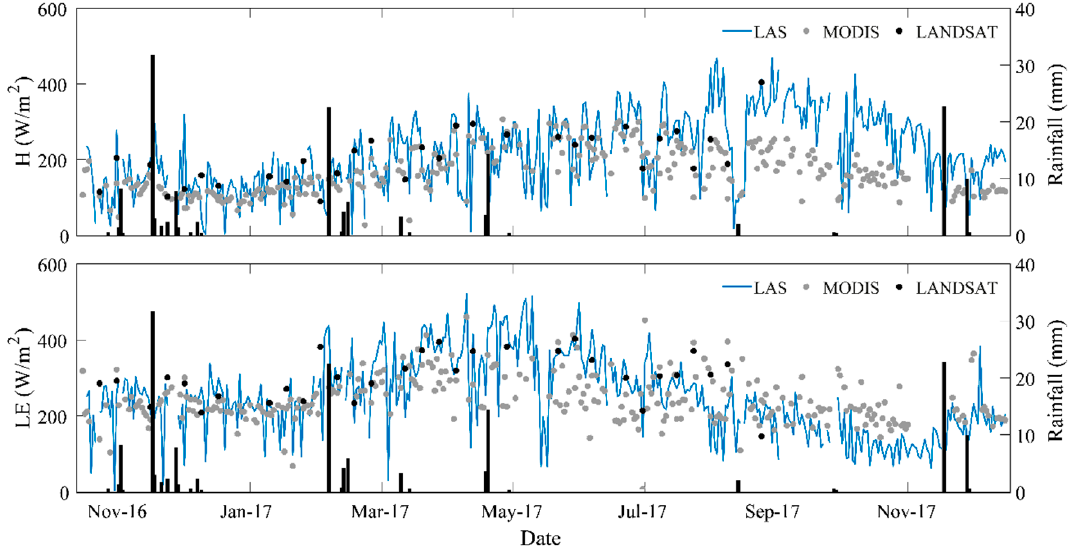
Figure 11. Time series of the LAS convective flux measurements (H and LE) at 11:00 a.m. and TSEB predictions based on MODIS and Landsat products.